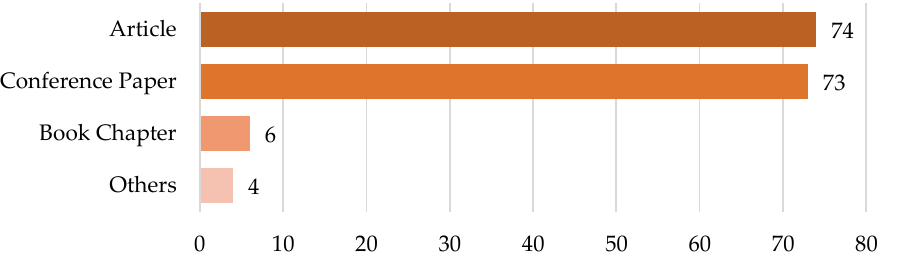
Figure 2. Overall amount of documents by type, according to the Scopus classification. The category Others collects two documents classified as Notes and two Errata.